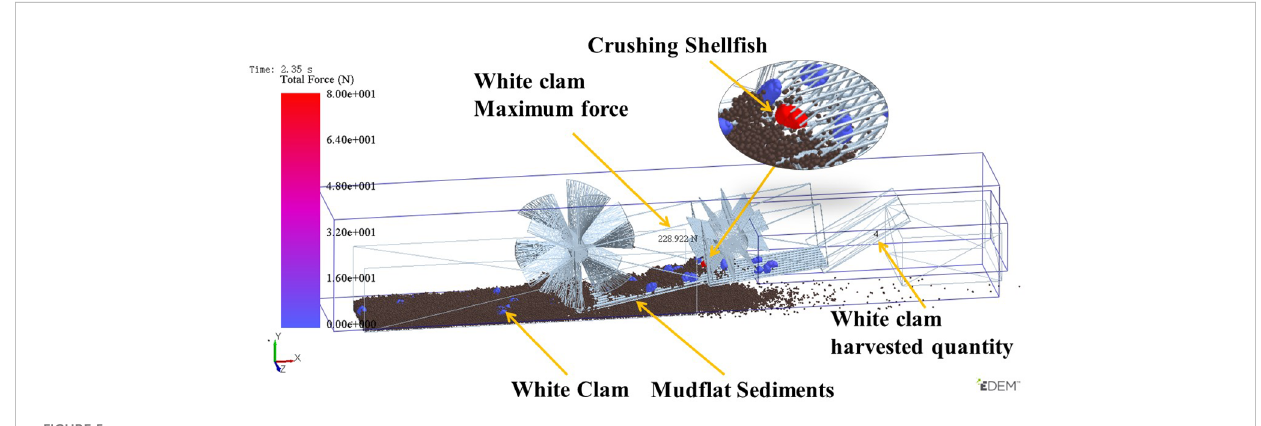
FIGURE 5 DEM simulation of shell fi sh vibratory